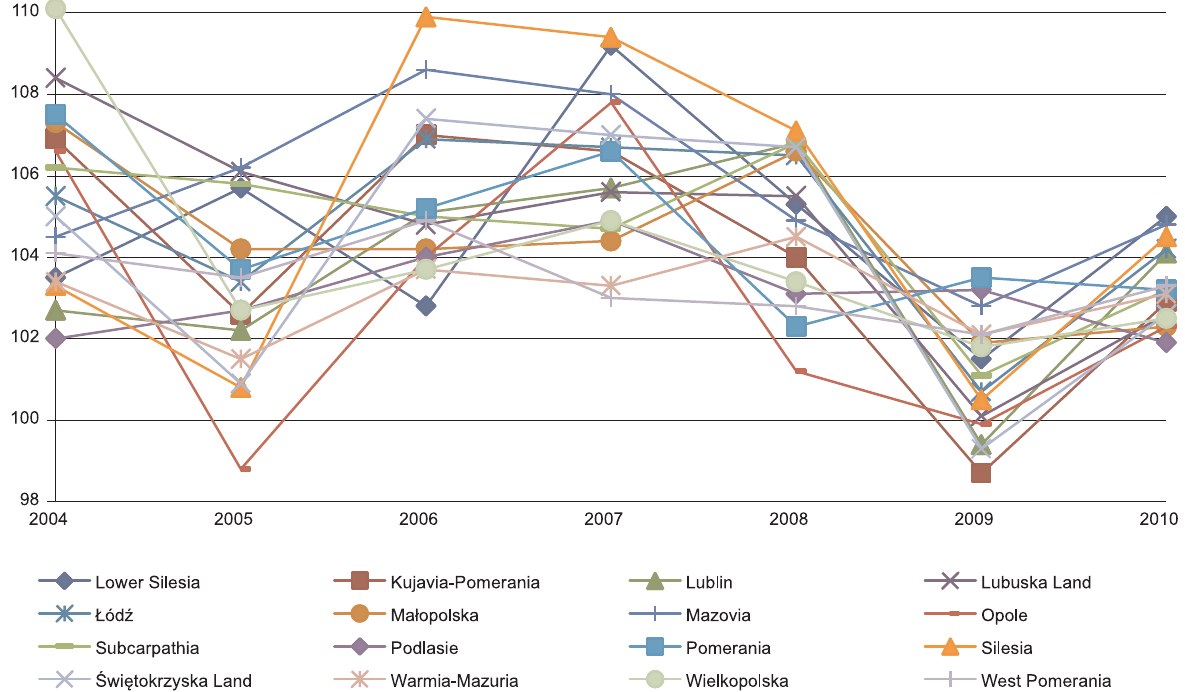
Fig. 2. Dynamics of per capita GDP by region (constant prices, previous year = 100) Source: own compilation on the basis of the Central Statistical Office’s 2012 data